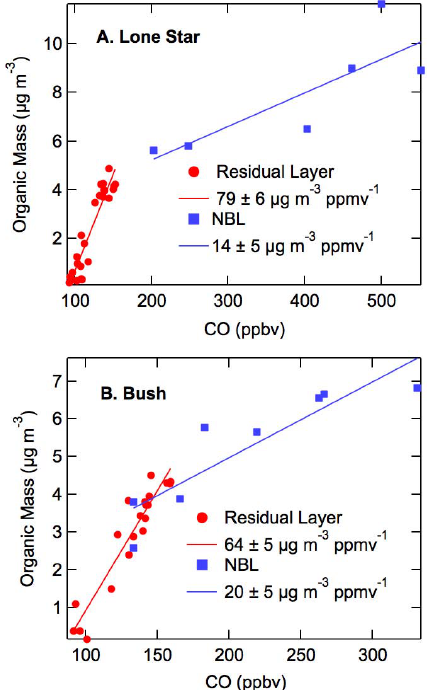
Fig. 15. Plot of organic aerosol mass (µgm − 3 ) from the AMS against carbon monoxide (CO) in ppbv for the profiles at (A) Lone Star and (B) Bush airfield on 12 October. Red and blue data points are for the residual and nocturnal boundary layers, respectively. Slopes of linear fits to each data set are shown in the